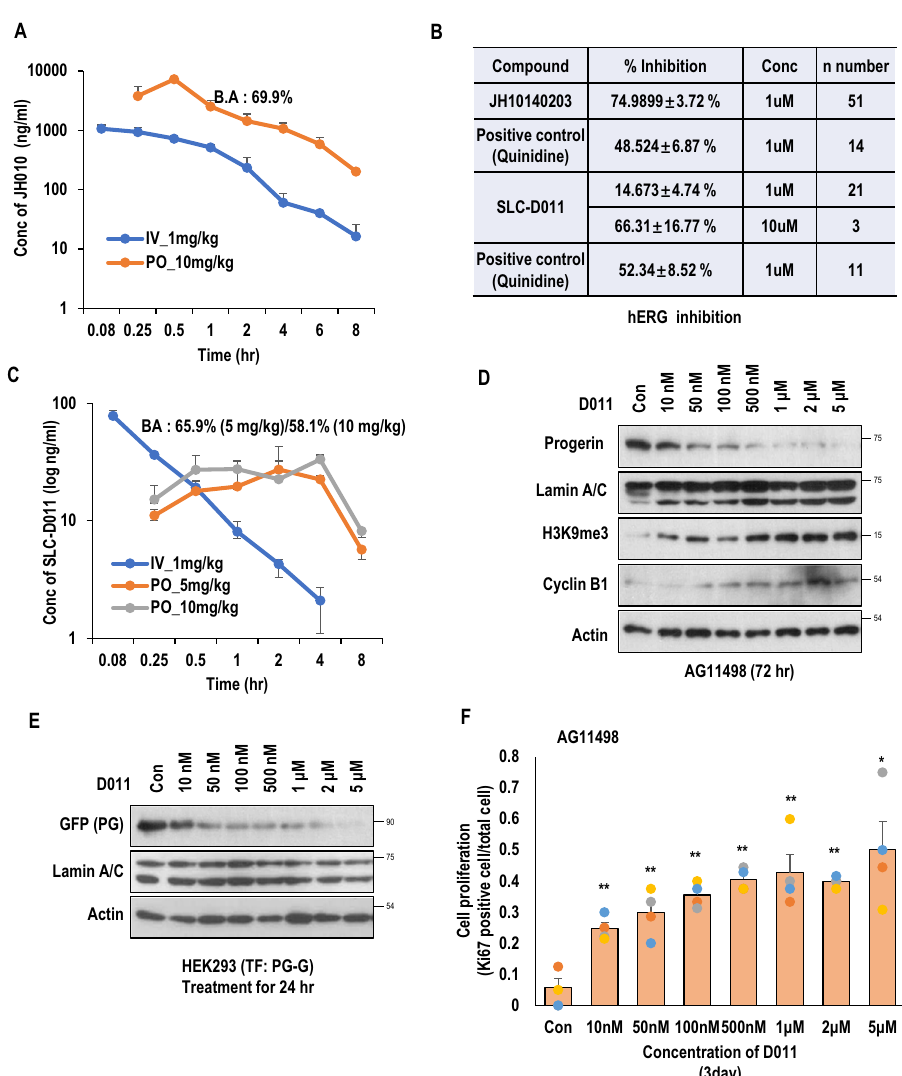
Fig. 2 Therapeutic effect of SLC-D011. A . In vivo pharmacokinetic (PK) analysis of JH010 (performed in rats). JH010 showed proper pharmacokinetic pro fi le and very high Bioavailability (B.A). B Effect of SLC-D011 on human ERG (hERG). SLC-D011 did not show severe hERG inhibition. C In vivo pharmacokinetic analysis of SLD-D011. D Treatment with low concentration of SLC-D011 (100 nM) for 3 days reduces progerin expression but induces H3K9me3 and cyclin B1 expression in HGPS patient-derived cells (AG11498, Coriell Cell Repositories, n = 3 independent experiment; two-tailed Student ’ s t test). E SLC-D011 eliminates exogenous progerin expression. HEK293 cells transiently transfected with GFP-PG vectors were treated with SLC-D011 for 24 hr ( n = 3 independent experiment; two-tailed Student ’ s t test). F SLC-D011 induces expression of Ki67 (a cell proliferating marker) in HGPS cells (AG11498, Coriell Cell Repositories). Ki67-positive cells were visualized at 3 days after treatment, and counted from photomicrographs ( n = 3 independent experiment; two-tailed Student ’ s t test), ** p < 0.001, * p < 0.05. “ Con ” means dimethyl sulfoxide (DMSO)-treated